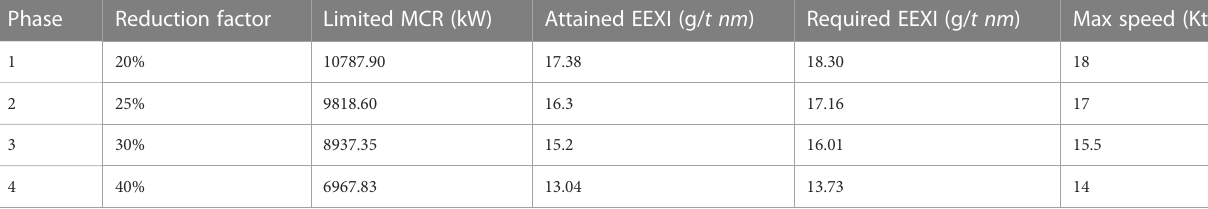
TABLE 6 Limited MCR under different EEXI